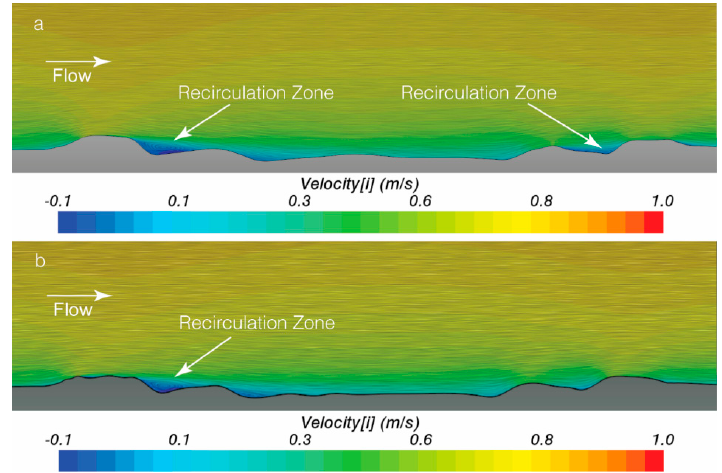
Figure 9. Mean streamwise velocity distribution of two valley sections: ( a ) Valley section one has a recirculation zone in the upstream and downstream valley; ( b ) Valley section two has one recirculation zone in the upstream valley.